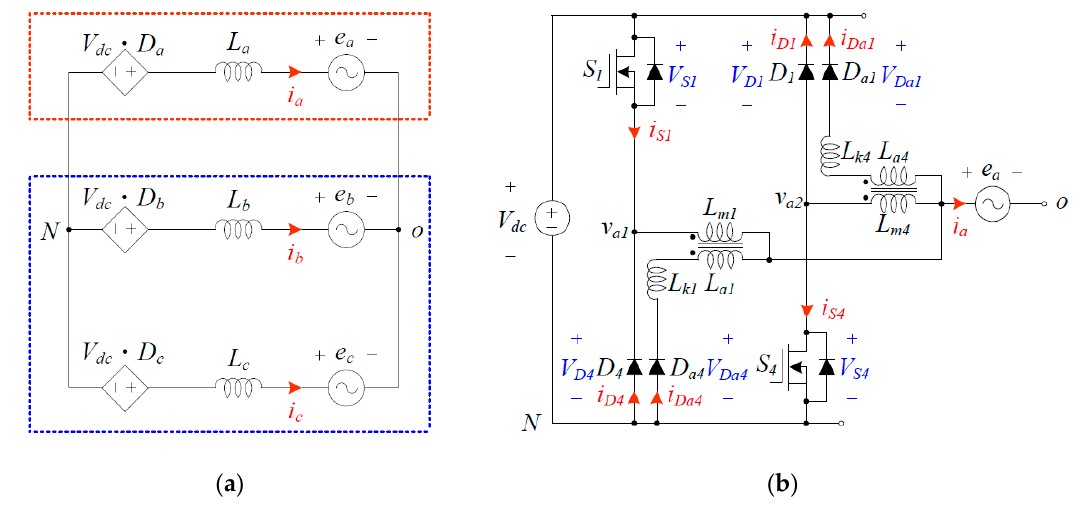
Figure 3. Switching-cycle average model and circuit diagram of the proposed inverter with reference directions of currents and voltages for A -phase: ( a ) switching-cycle average model; ( b ) circuit diagram for A -phase.